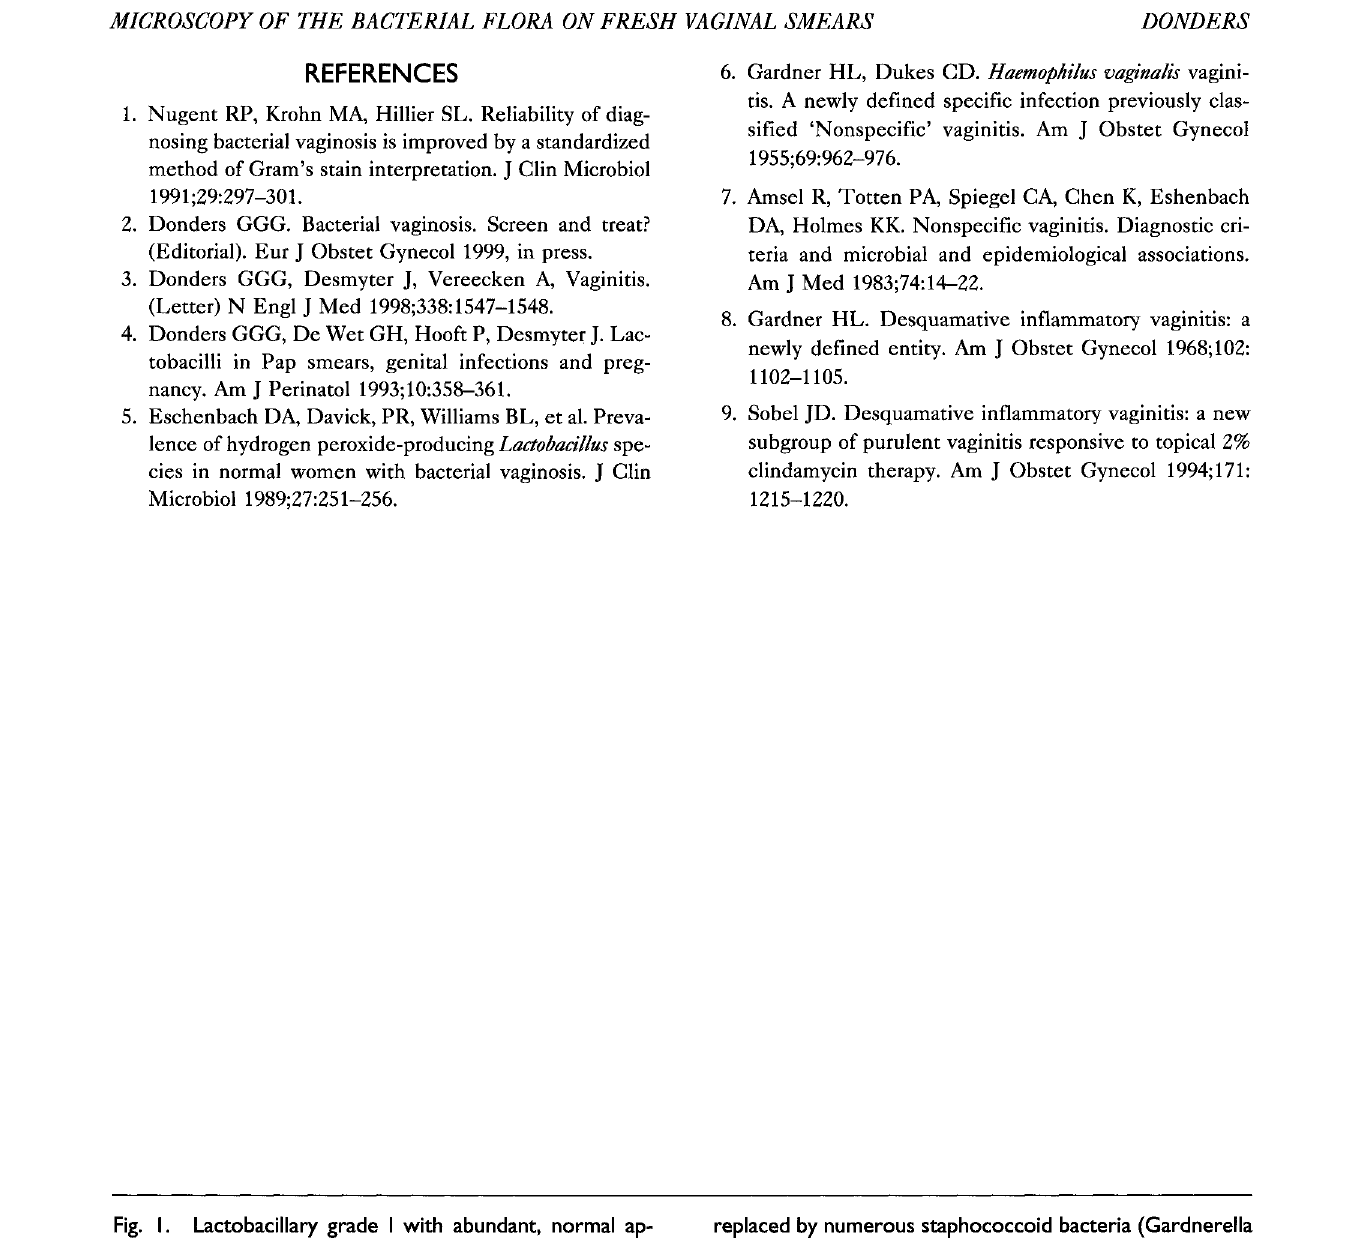
replaced by numerous staphococcoid bacteria (Gardnerella morphotypes). They form a granular carpet, as if "a sac of grain has been teared and spread on the floor." Clue cells, not shown in this picture, can readily be found. Note the typical absence of leukocytes in uncomplicated cases. Fig. 6. Lactobacillary grade II1: aerobic vaginitis. Few, if any, lactobacillary morphotypes are seen, all of them being replaced by coccoid bacteria, often arranged in little chains or trains of 2 to 6 bacteria, such as in the case of group B streptococci. In more severe cases, as shown here, the numerosity of the leukocytes is striking, some of them filled with vividly vibrating granules, corresponding to lysosomes and phagosomes in these "toxic leukocytes." In the most severe cases, 10 to 50 percent of the epitheliocytes are in an immature, parabasal state, such as epitheliocyte shown in lower right corner. This extreme end of aerobic vaginitis is also named "desquamative inflammatory